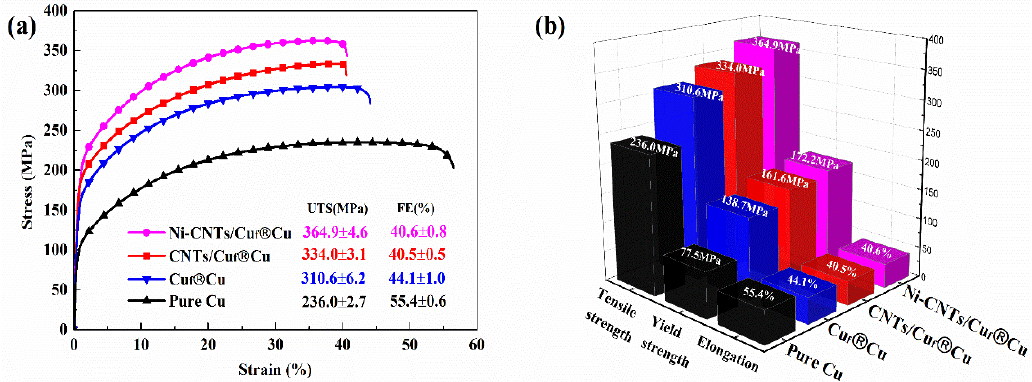
Figure 7. ( a , b ) The tensile stress–strain curves of pure Cu and composites.